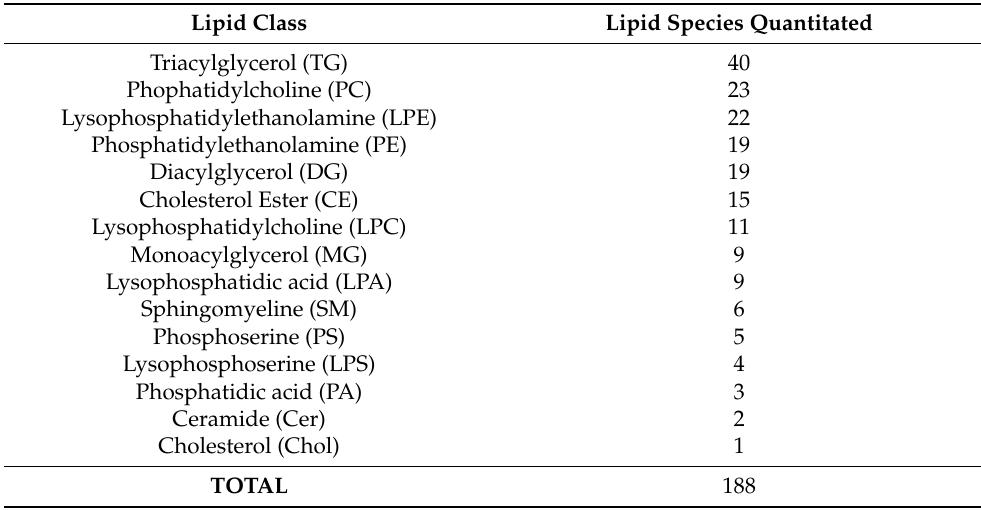
Table 1. The classes of lipids in GrEVs and GrEXs detected by liquid chromatography–mass spec- trometry. The number of identified lipid species in each lipid class was shown in descending order.